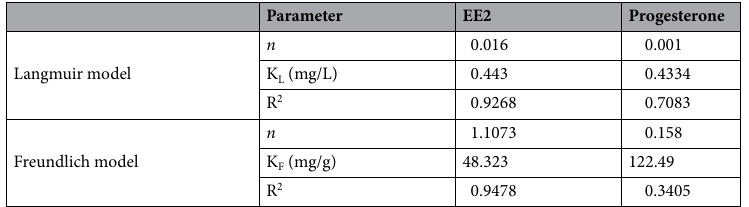
Table 3. Parameters of the adsorption isotherm following Langmuir and Freundlich models for 17α-ethinylestradiol (EE2) and progesterone, where R 2 is the determination coefficient, n is the heterogeneity parameter and K L and K F are the constants of Langmuir and Freundlich models, respectively.